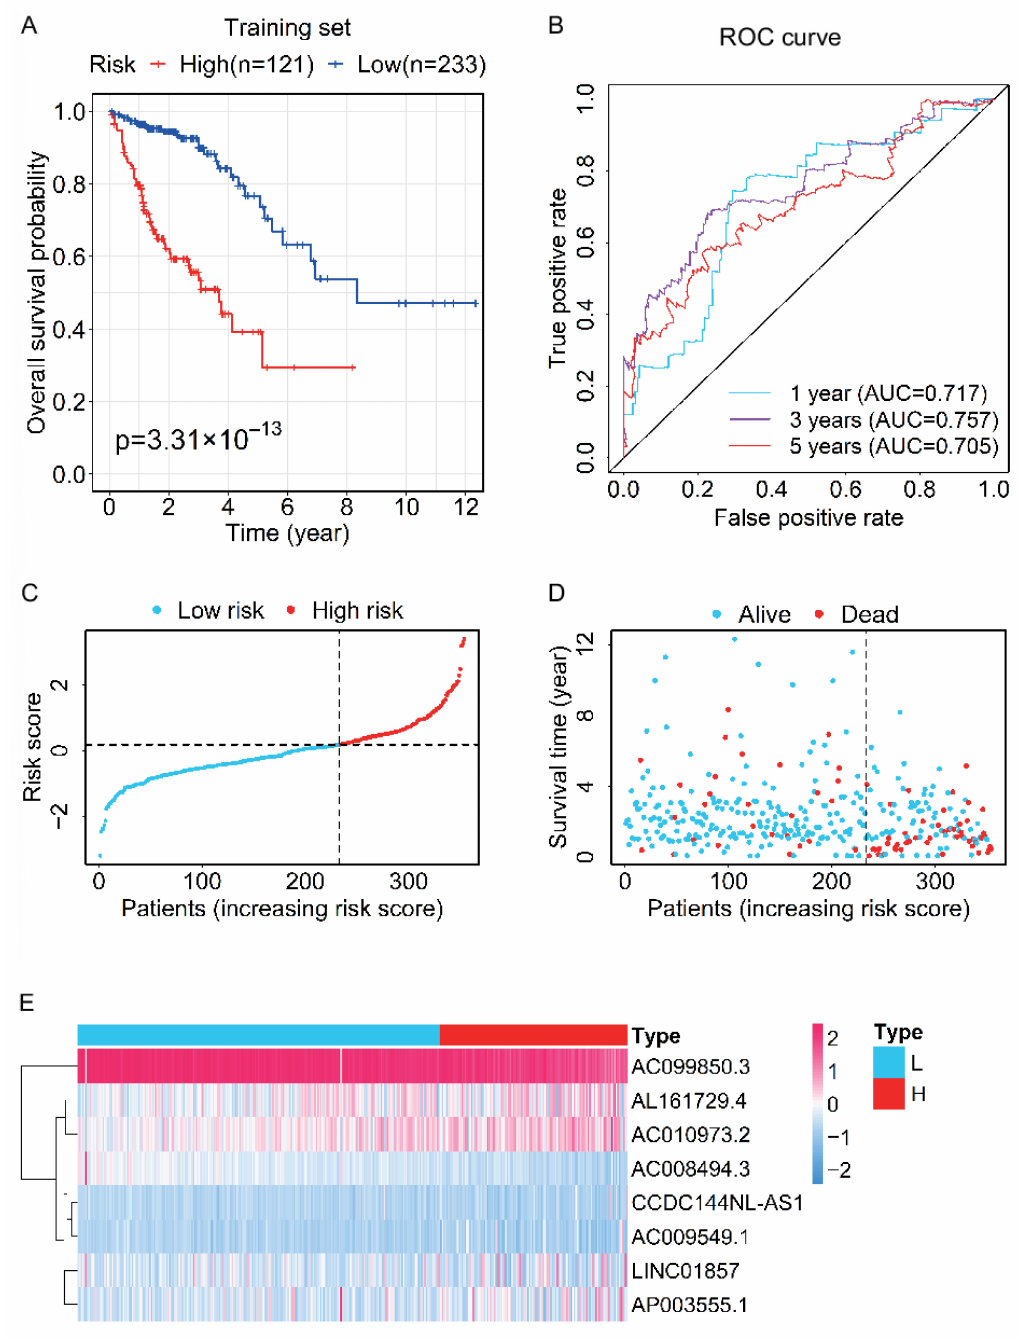
Figure 2. Evaluation for the prognostic value of the lncRNA signature in the training set. ( A ) Kaplan– Meier survival curve for OS of CRC patients in the high- and low-risk groups. ( B ) The time-dependent ROC curves of OS based on the risk score indicate the prognostic accuracy of the 8-lncRNAs signature. ( C ) The distribution of risk scores of CRC patients. ( D ) The scatter plot shows the overall survival time and survival status of CRC patients in the high- and low-risk groups. ( E ) Heatmap of clustering analysis for the expression of eight ferroptosis-related lncRNAs. L, low risk; H, high